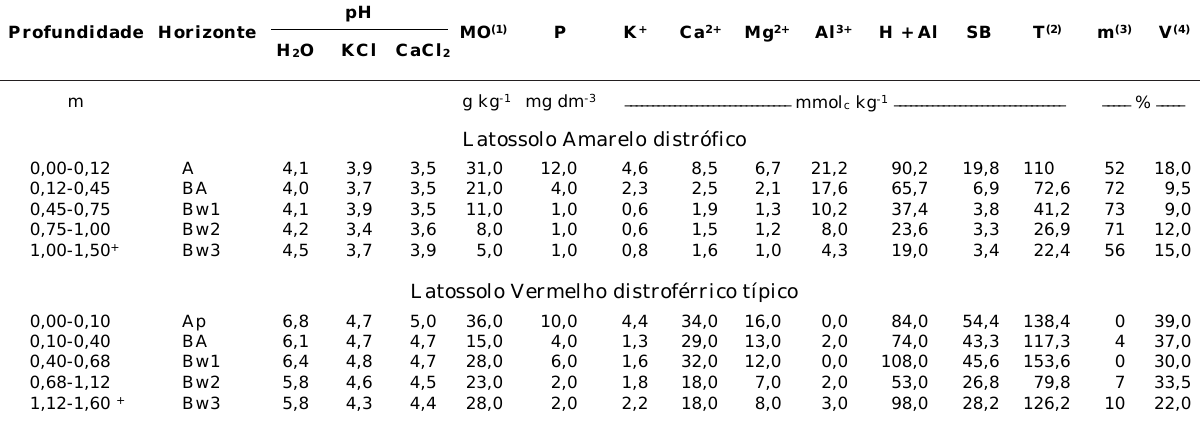
Densidade Densidade Por. total Macropor. do solo dos sólidos